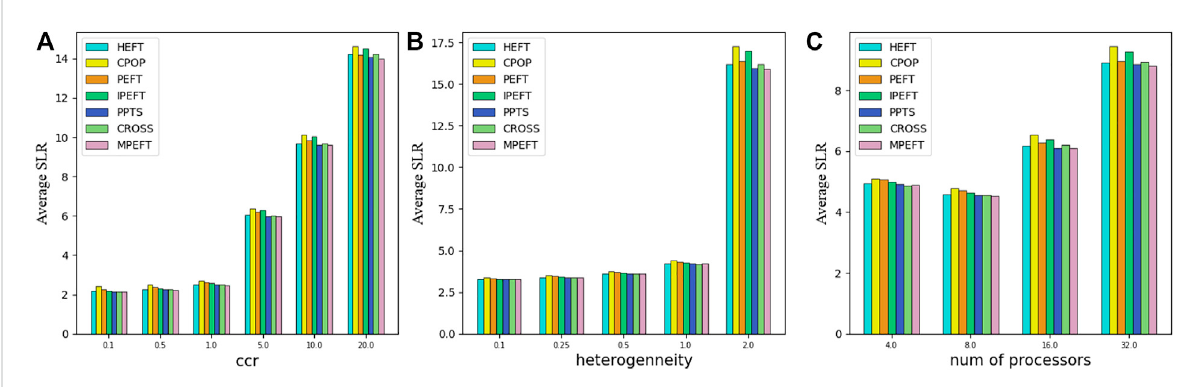
FIGURE 9 Average SLR as function of ccr (A) , heterogeneity (B) and number of processors (C) for Cybershake Work fl ows.